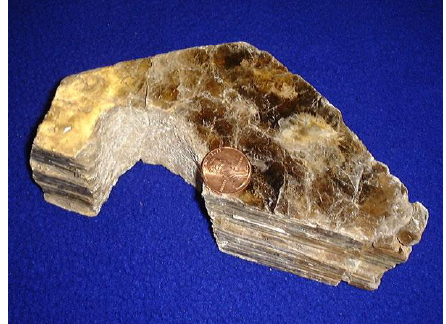
Figure 4. The Mica in its natural state. It looks like a piece of stone. It can be divided into flakes and can provide thin sheets.